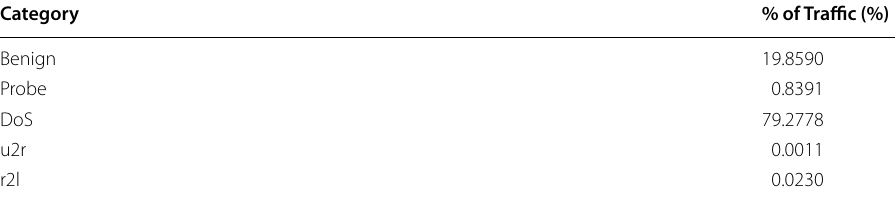
Table 2 % of benign and attack traffic in KDD99 Category